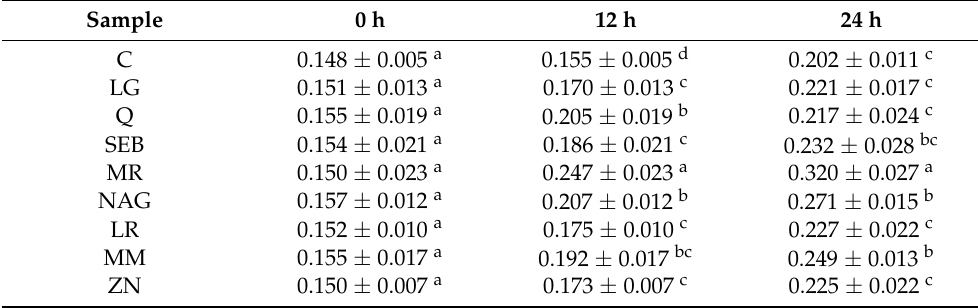
Table 5. Least square means for protease activity (absorbance) of Streptococcus thermophilus STI-06 over an incubation period of 24 h as influenced by added ingredients.